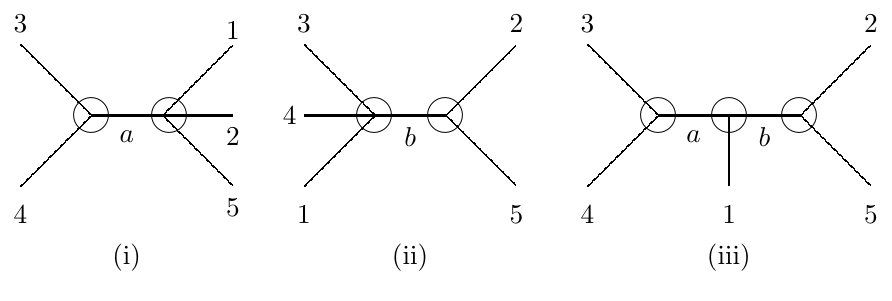
Figure 2 . Examples of boundaries C ( k ) s C (1) and the right (cid:12)gure describes C (2) b